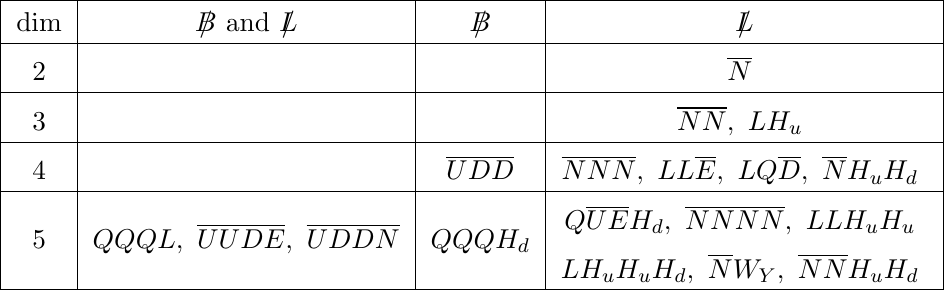
Table 5 . The baryon/lepton number violation operator in the superpotential. Note that the dimension of operators refers to the mass dimension in terms of the Lagrangian after the integration of the Grassmann coordinates. The operator W Y means the Yukawa coupling in eq.